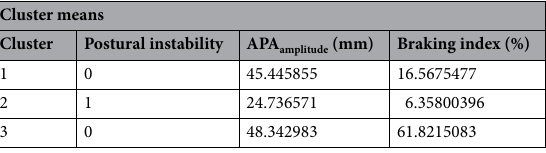
Table 4. K-Means clustering method. K cluster = 3, CCC best = 4.82779, Step = 5 Eigenvalues 2.996682, 0.5347658, 0.4685522, 0